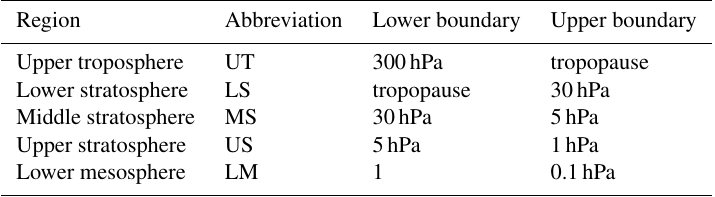
Table 8. Definitions and abbreviations of different atmospheric regions as used in this study. The full height range corresponds to about 9–65km. The tropopause is latitude dependent (approx. 200–300hPa in the extratropics and 80–100hPa in the tropics depending on season), while the transition between the stratosphere and the mesosphere (i.e., the stratopause) is here defined uniformly across all latitudes as the 1hPa pressure level. Note that the abbreviations are often used in combination (e.g., UTLS for upper troposphere and lower stratosphere and USLM for upper stratosphere and lower